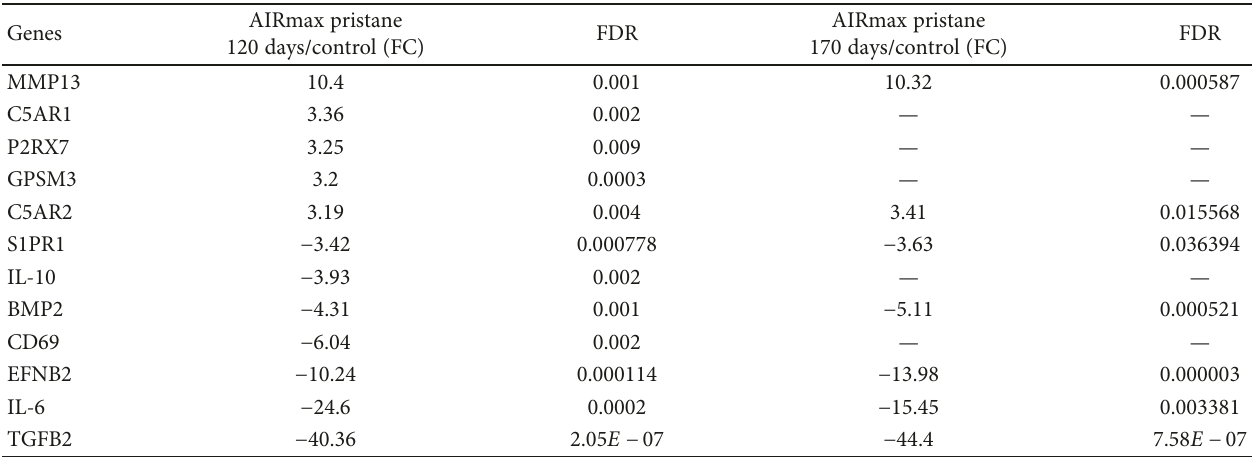
Table 1: Genes involved with human RA and experimental arthritis models, up- and downregulated in AIRmax mice after pristane injection ( n = 5 per group). Signi fi cant fold change (FC) was calculated using one-way ANOVA, with FDR < 0 05 .